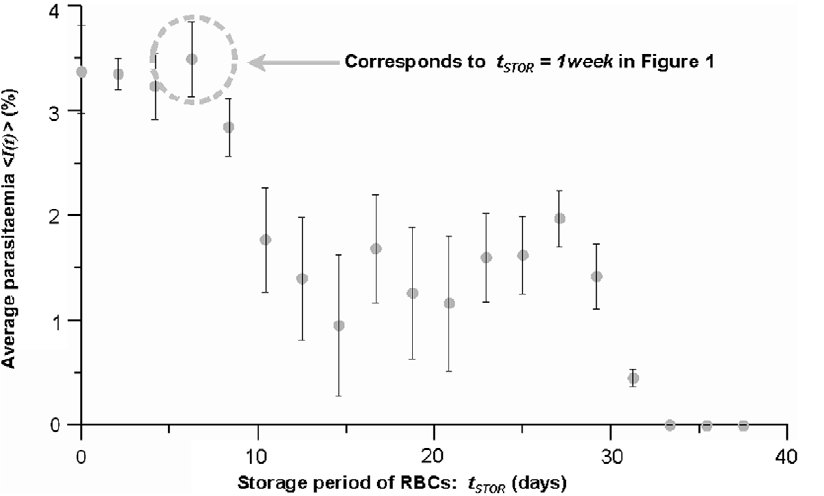
Figure 2. Simulated effect of the storage of RBCs on the culture performance. Average parasitaemia through the culture decreases with the storage time of RBCs. Grey dots show the mean values obtained from two sets of simulation trials that included sub-cultivations every 48 h, 72 h and 96 h. Errors bars reflect the variability in the simulations.